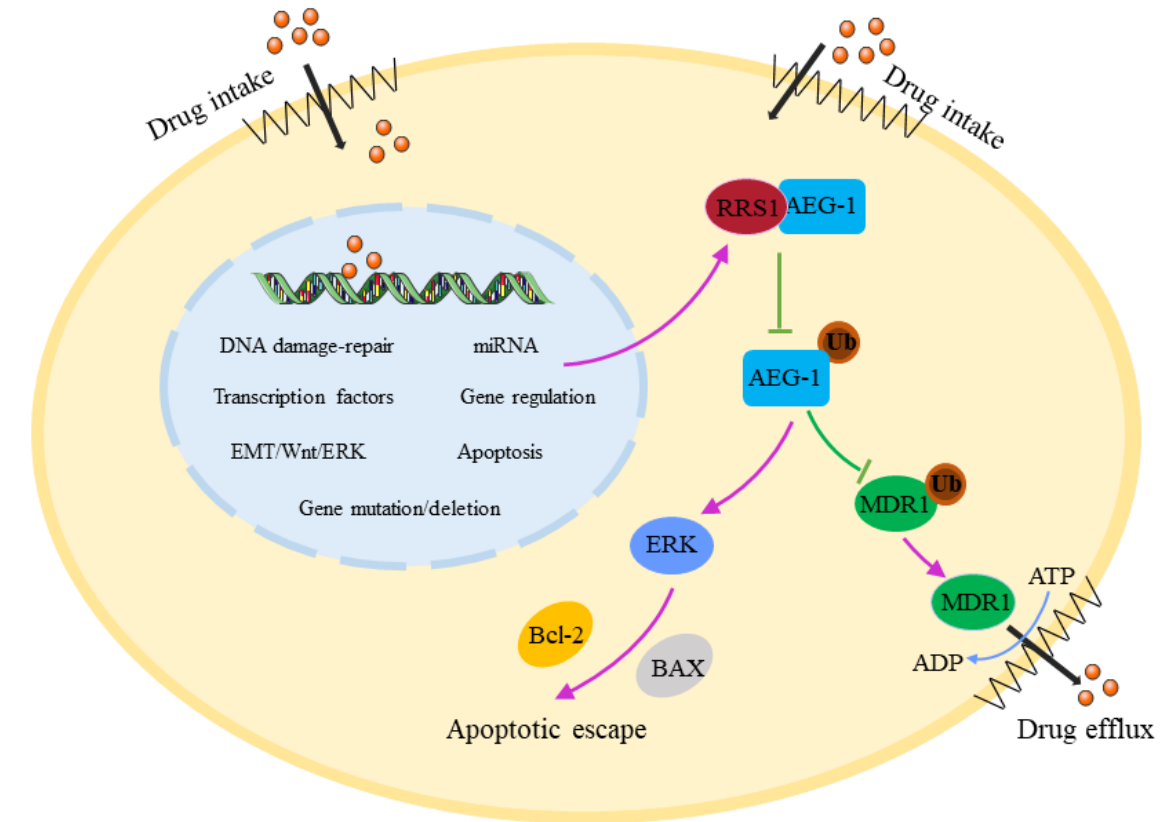
Figure 6. The mechanism of RRS1-regulated cisplatin resistance in breast cancer cells.